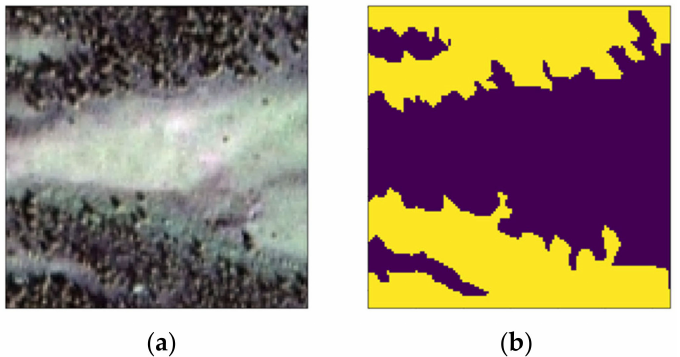
Figure 3. The sample and ground truth visualization for an example within the proposed dataset: